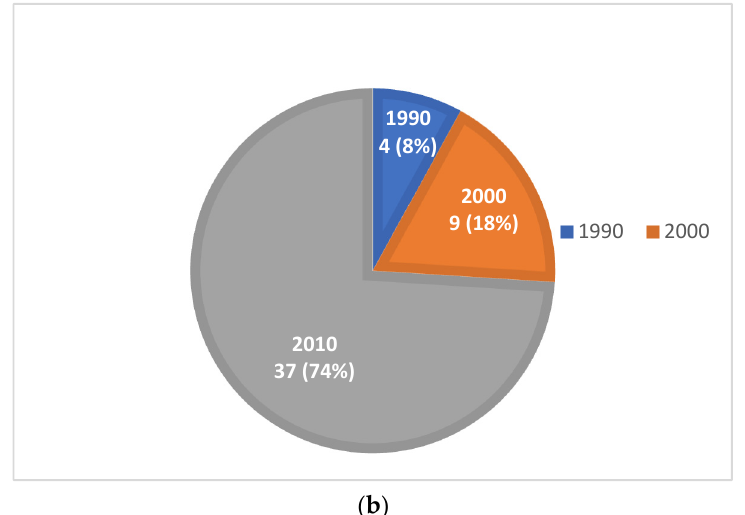
Figure 2. ( a ): Time distribution of the top 50 most-cited articles in WMSDS related to healthcare practitioners using RULA. ( b ): Time distribution of the top 50 most-cited articles in WMSDS related to healthcare practitioners using NMQ.